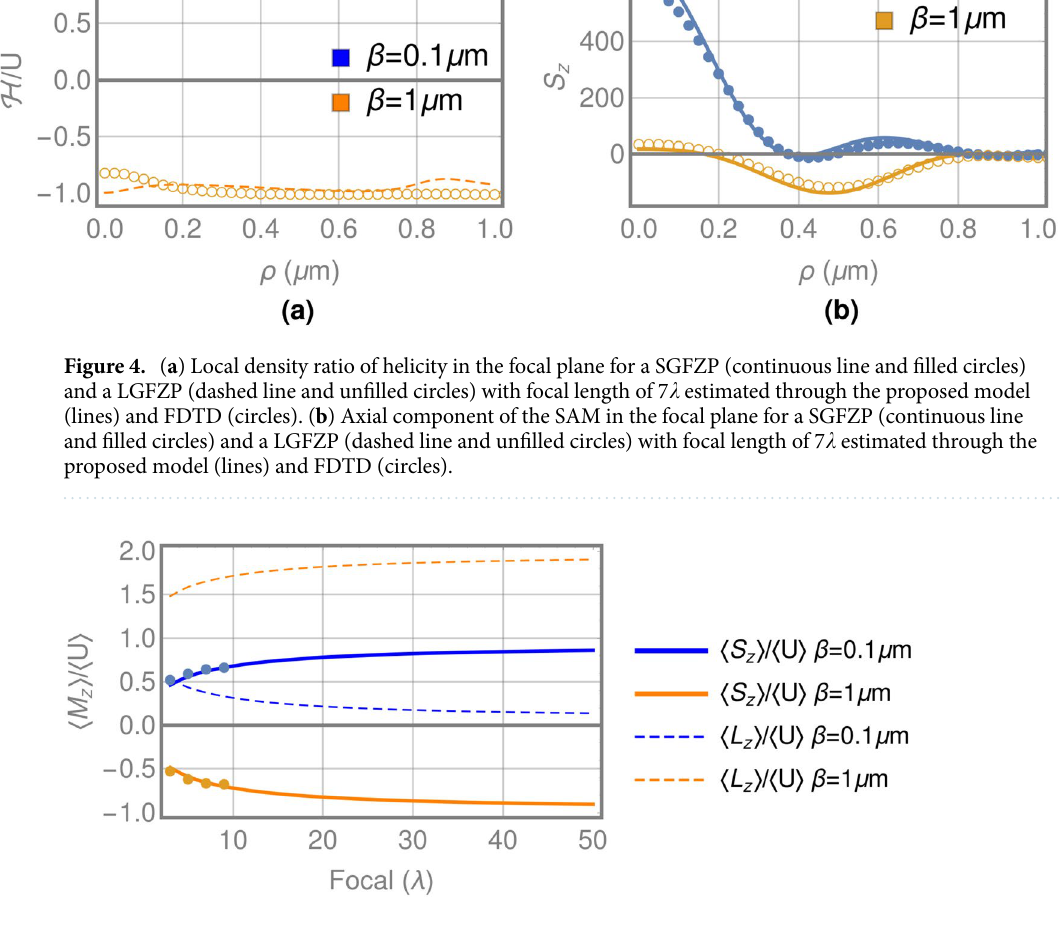
Figure 5. Evolution of SAM and OAM in the focal plane generated by SGFZP and LGFZP as a function of the focal length of the zone plate (points indicate the results of